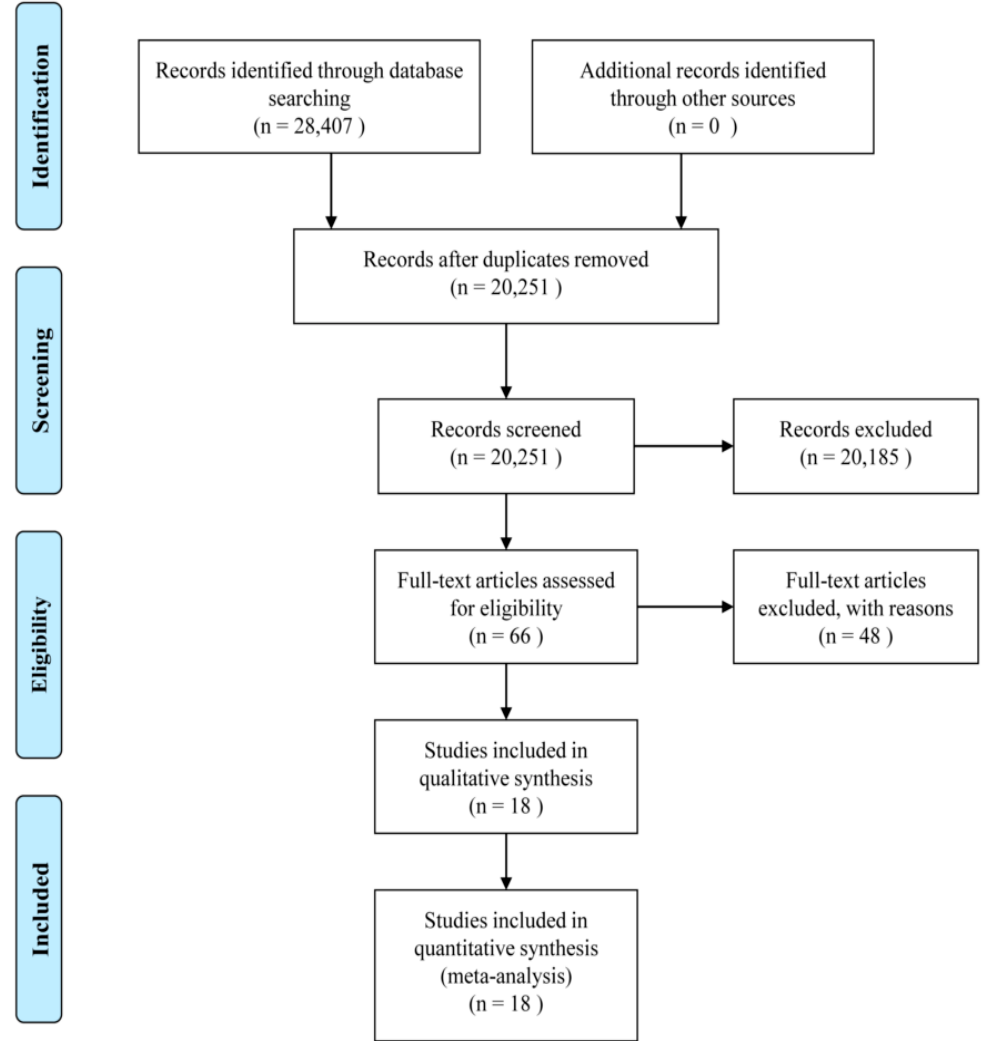
Figure 1. Preferred Reporting Items for Systematic Reviews and Meta-Analyses (PRISMA) diagram for study selection.